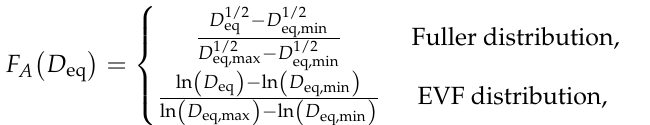
Figure 5. The meso-scale model of polyphase concrete composed of pentagonal coarse aggregates, oval fine aggregates, ITZ and homogeneous matrix ( D eq = Fuller 1.0–4.5 mm for ovals, D eq = Fuller 5–20 mm for regular polygons).